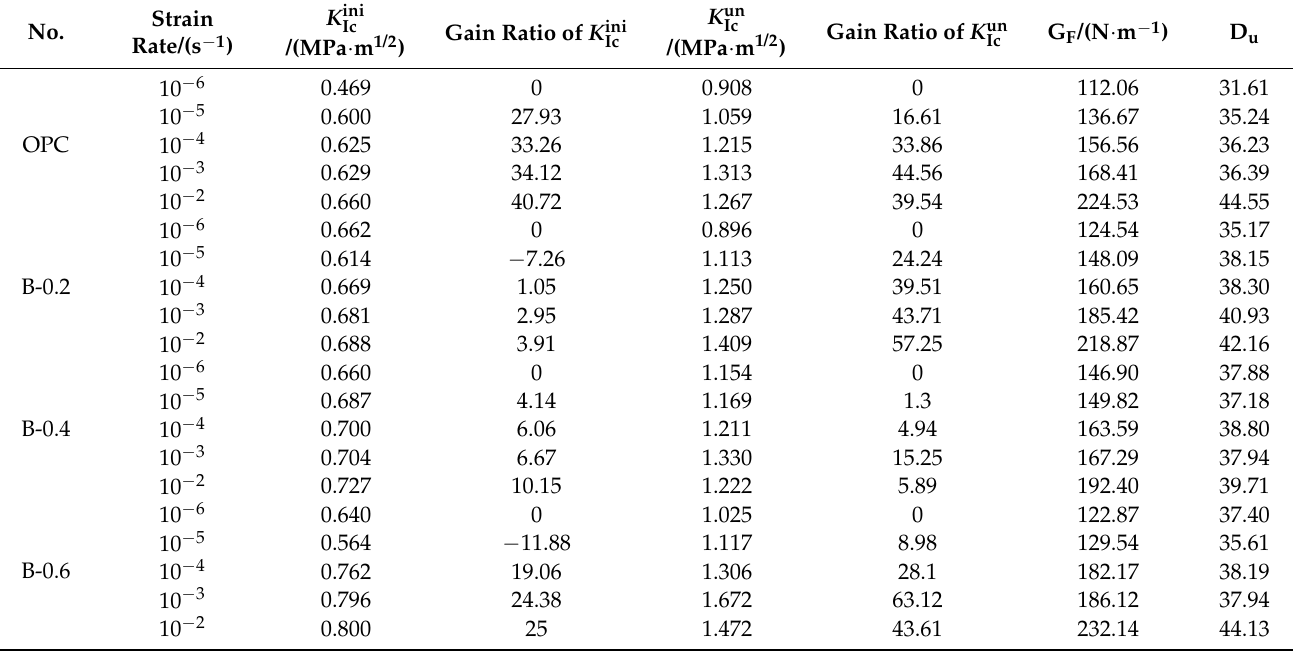
Table 4. Related fracture parameters of concrete under different loading